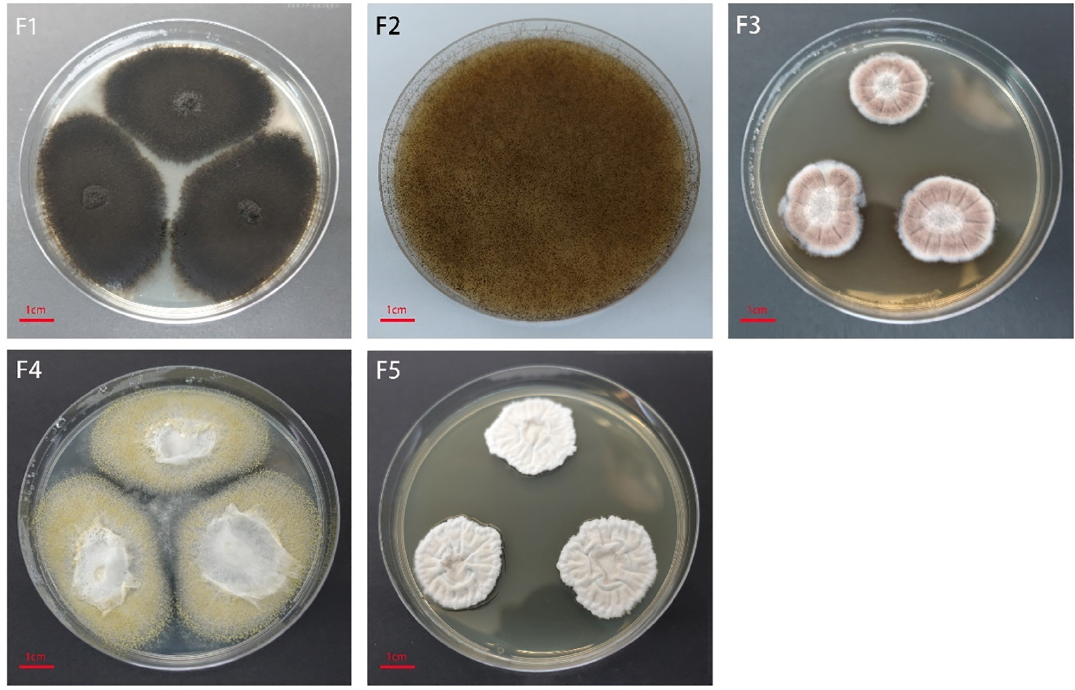
Figure 4. Rarefaction curves for the sunflower seed kernels. A1–A3, unmildewed (2018–2020); B1–B3, mildewed (2018–2020).